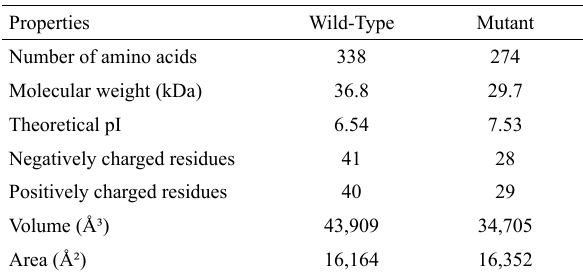
Table 2 – Comparison of physical chemical properties of wild-type and NP_000498.2:p.(Lys204ArgfsTer32) mutant